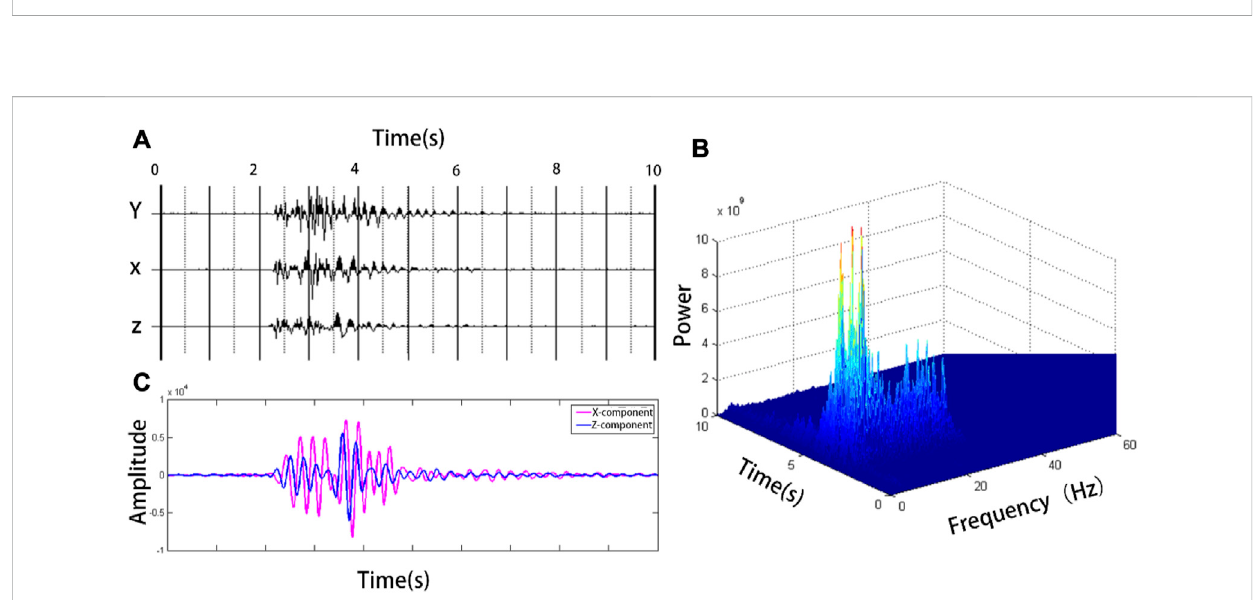
FIGURE 11 (A) shows the horizontal and vertical component seismic records of the Rayleigh wave dominant microtremor signal, and (B) shows the time- frequency distribution of the vertical component in (A) ; (C) is the comparison of seismic records after bandpass fi